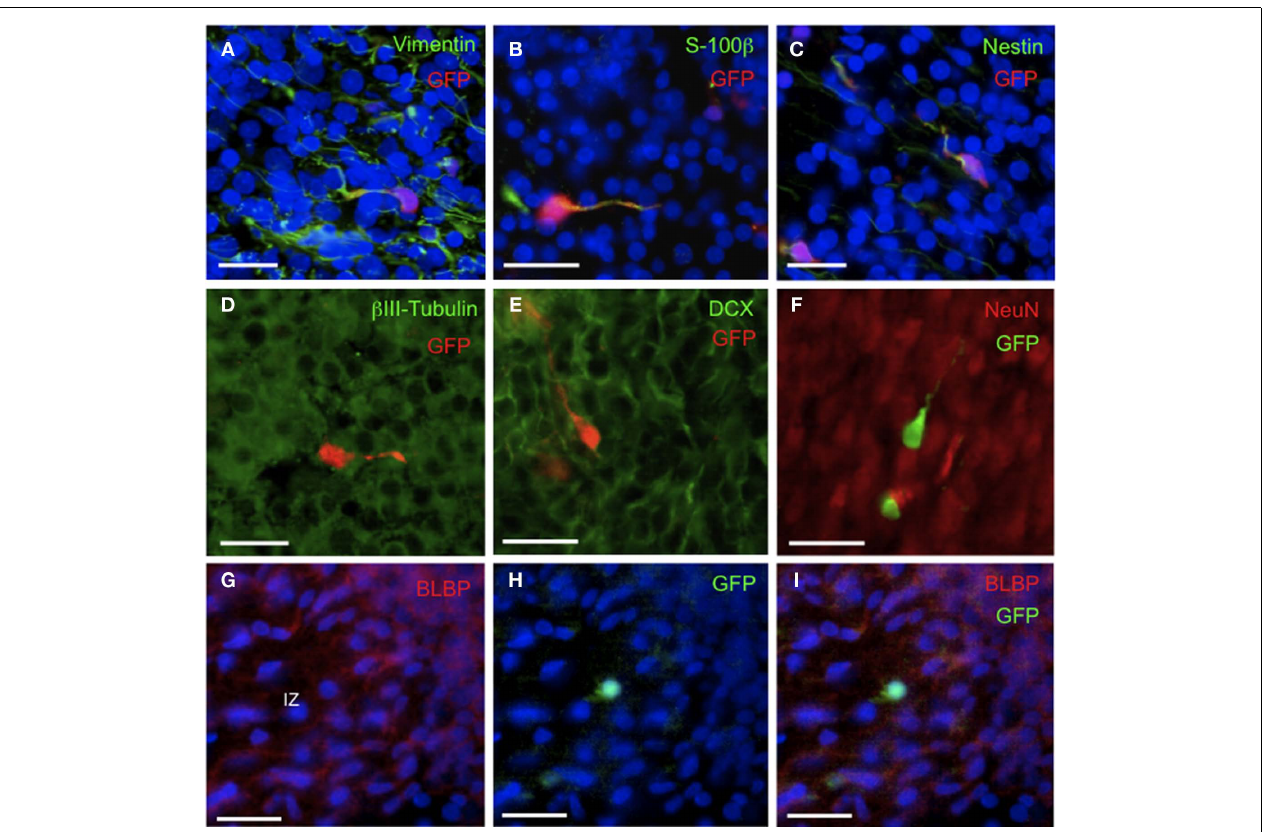
GFP with β III-tubulin, DCX, and NeuN. (G) Note BLBP + processes coursing through the IZ. (H) Note a single GFP + cell in the IZ. (I) Note absence of co-localization of GFP with BLBP. Scale bars = 20 μ m. Abbreviations: BLBP, brain lipid-binding protein; DCX, doublecortin; GFP, green fluorescent protein; IZ, intermediate